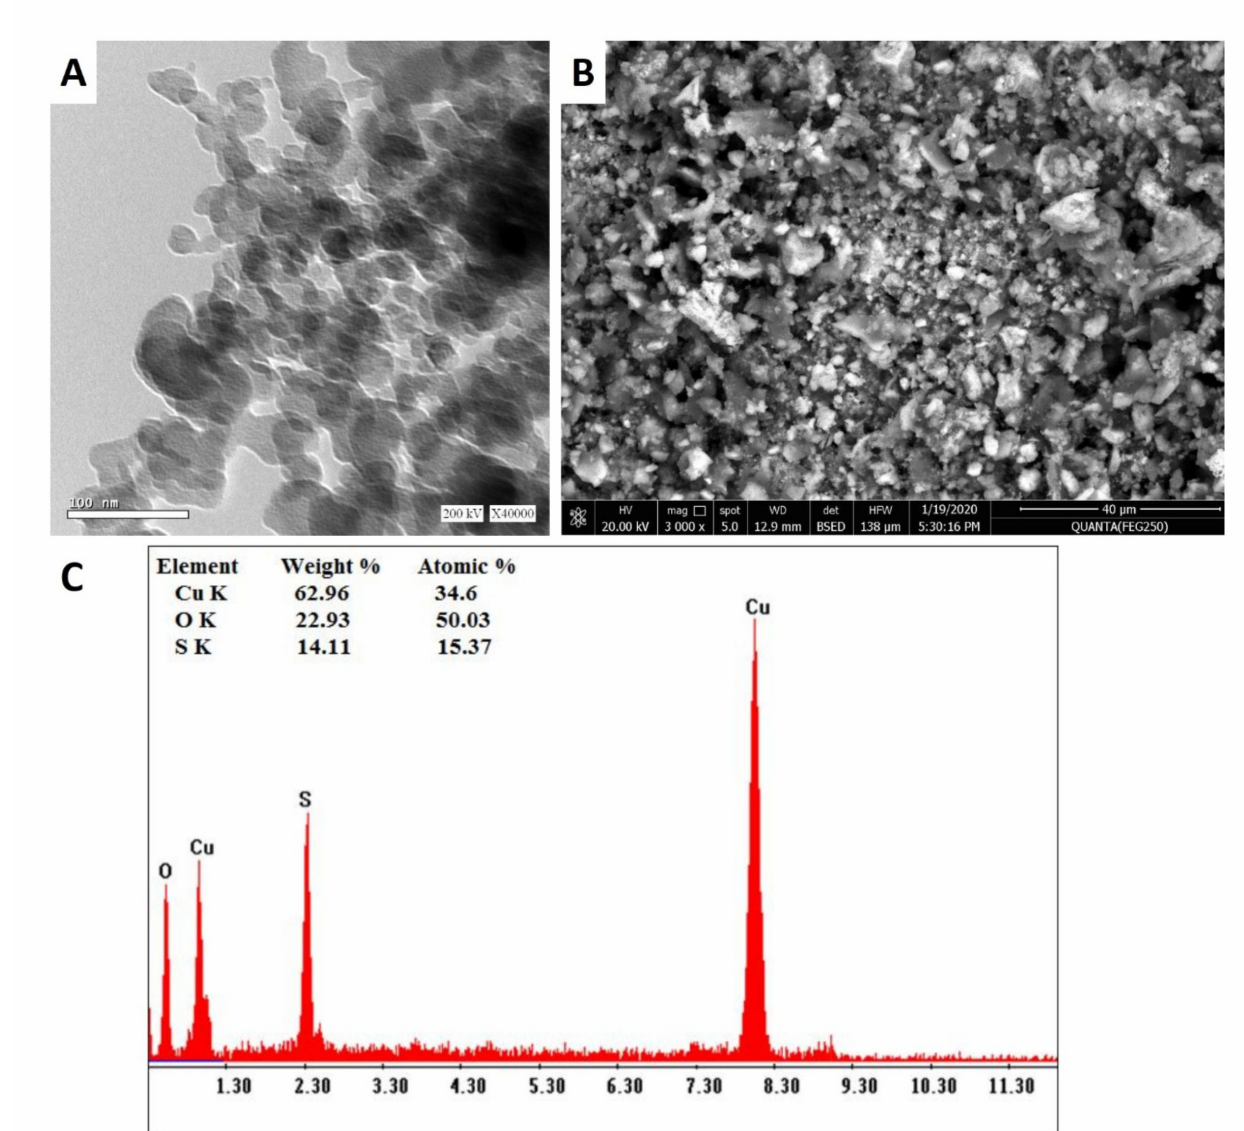
Figure 2. Characterization of CuO-NPs synthesized by A. niger G3-1; ( A ) transmission electron microscopy (TEM); ( B ) and ( C ) denote SEM-EDX spectra of biosynthesized